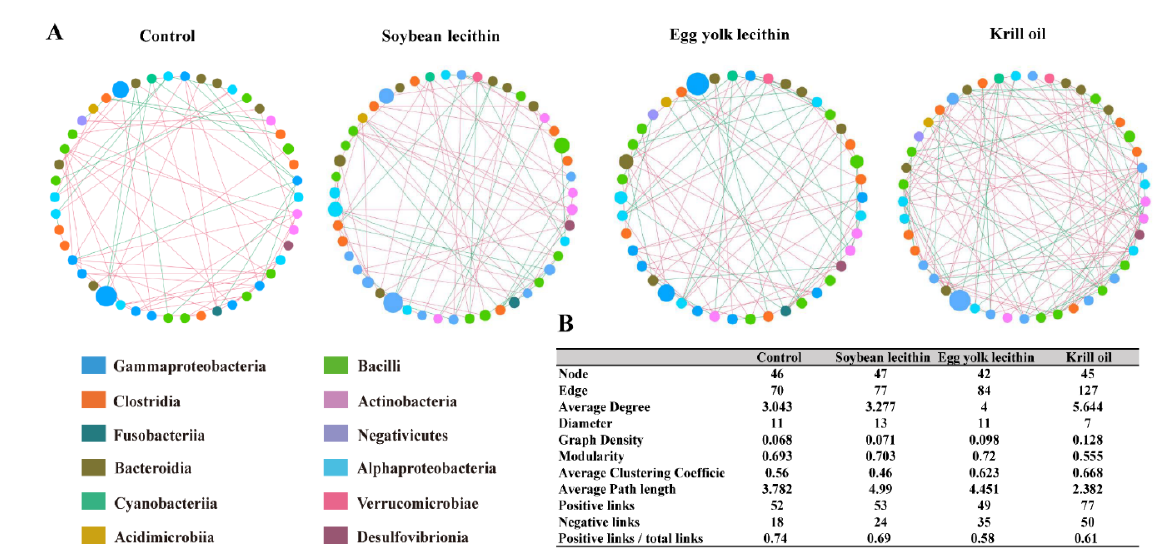
Figure 9. Ecological interaction network analysis of gut microbial community. ( A ) Interspecies interaction network of bacteria communities for female L. vannamei fed with different phospholipids. Each node represents a genus. Node colors indicate genus affiliated with different classes. A green edge indicates negative correlations between two individual nodes, whereas a red edge indicates positive correlations. ( B ) Topological properties of gut microbial community networks.